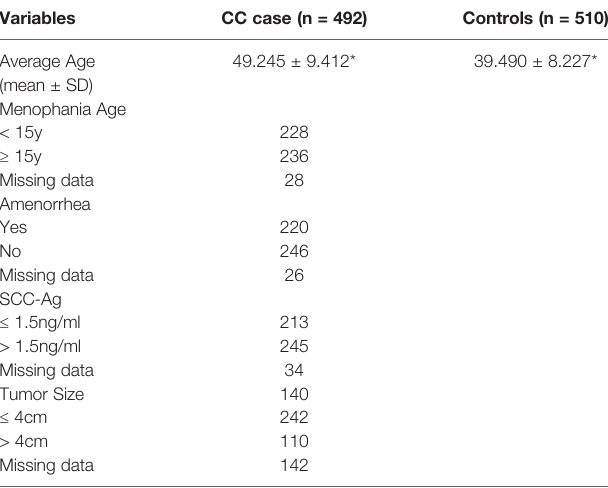
TABLE 2 | The distribution of clinical features of CC patients and